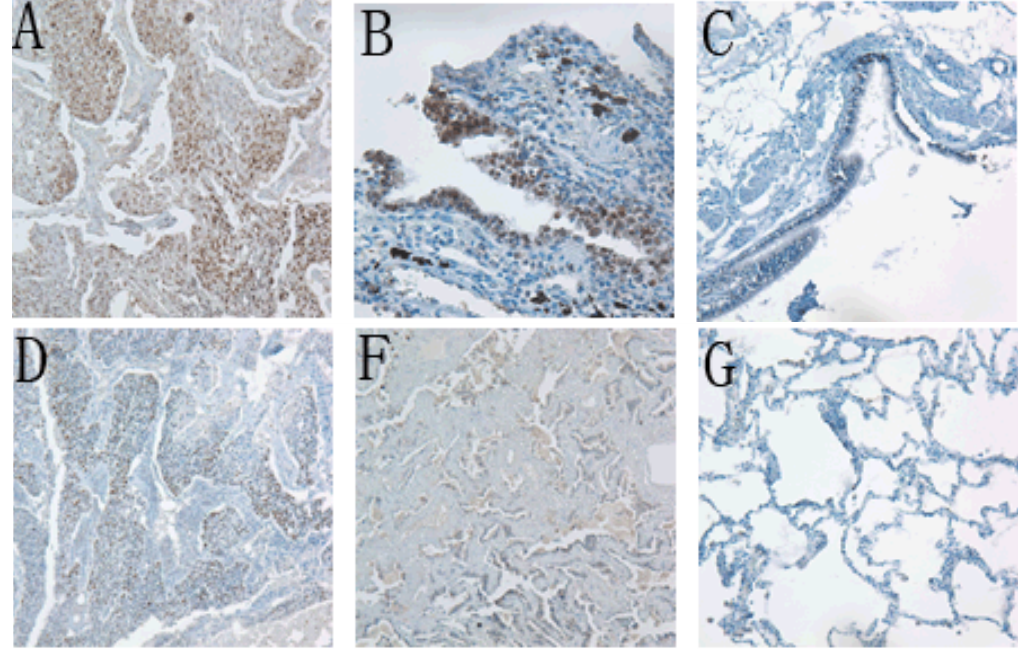
Figure 1. Representative expression patterns of Sox2 ( A – C ) and Oct4 ( D – F ) in cancerous tissues and their corresponding paracancerous tissues. Brown grains represent a positive signal. The positive expression site of Sox2 and Oct4 was mainly localized in the nucleus of tumor cells. Sox2 positive expression in lung squamous cell carcinoma (SCC) ( A ) and lung adenocarcinoma ( B ); Sox2 expression negative in paracancerous tissue ( C ); Oct4 staining positive in lung SCC ( D ) and lung adenocarcinoma ( E ); Oct4 negative expression in paracancerous tissue ( F ) .